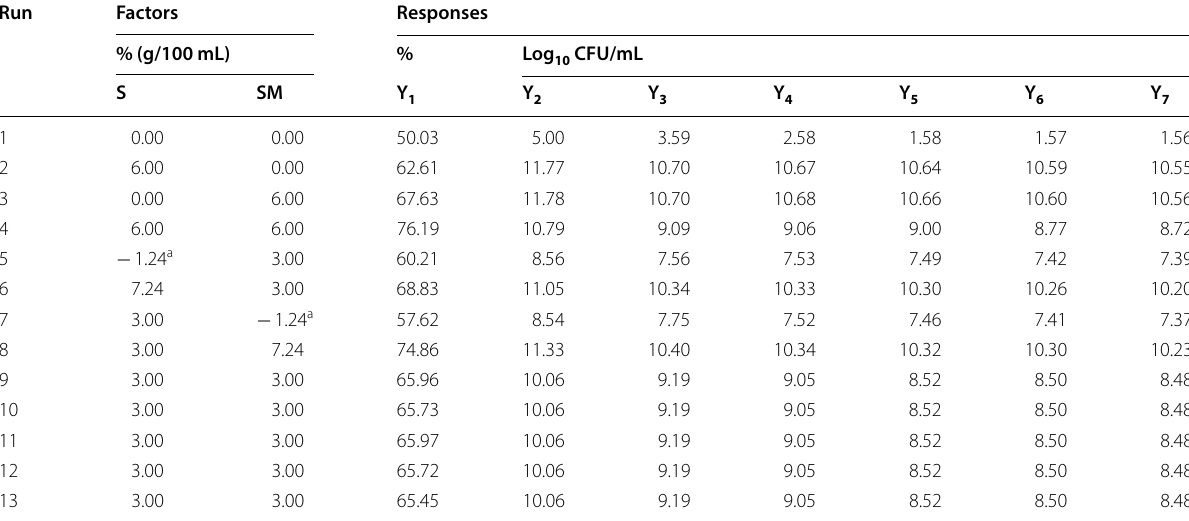
Table 3 Experimental design and responses after lyophilization